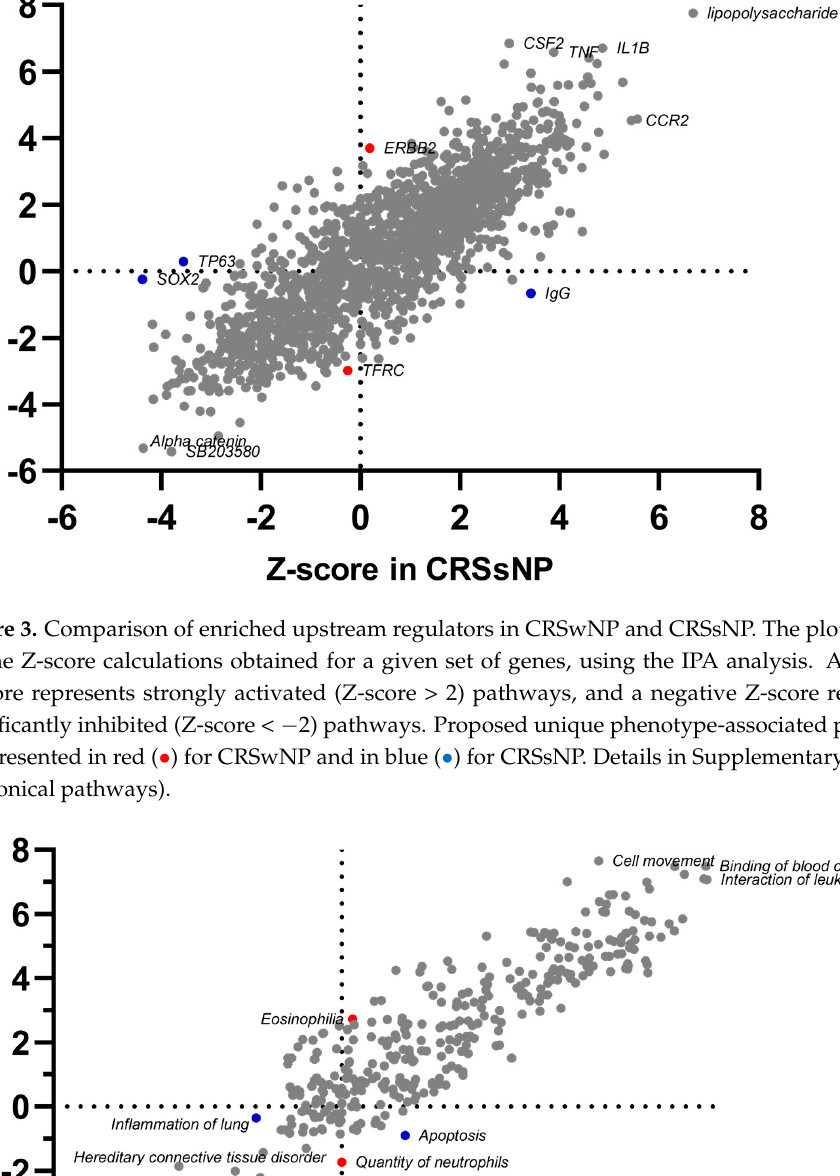
Figure 4. Comparison of enriched diseases and functions in CRSwNP and CRSsNP. The plot is based on the Z-score calculations obtained for a given set of genes, using the IPA analysis. A positive Z-score represents strongly activated (Z-score > 2) pathways, and a negative Z-score represents significantly inhibited (Z-score < − 2) pathways. Proposed unique phenotype-associated pathways are presented in red ( • ) for CRSwNP and blue ( • ) for CRSsNP. Details in Supplementary Table S4 (Diseases and